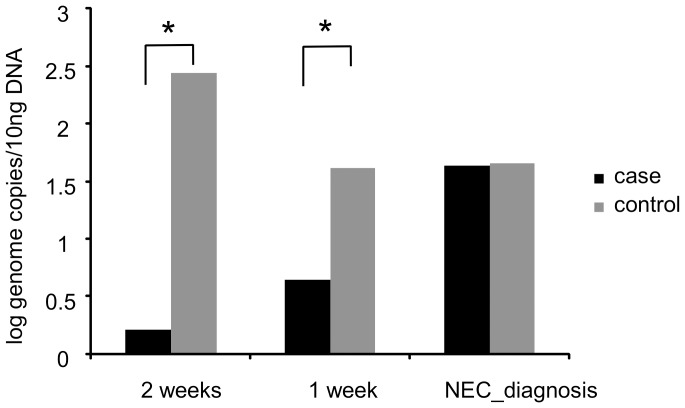
qPCR for fecal counts of Bifidobacteria.* p-value 2 weeks before NEC <0.05; **p-value week of NEC <0.05.